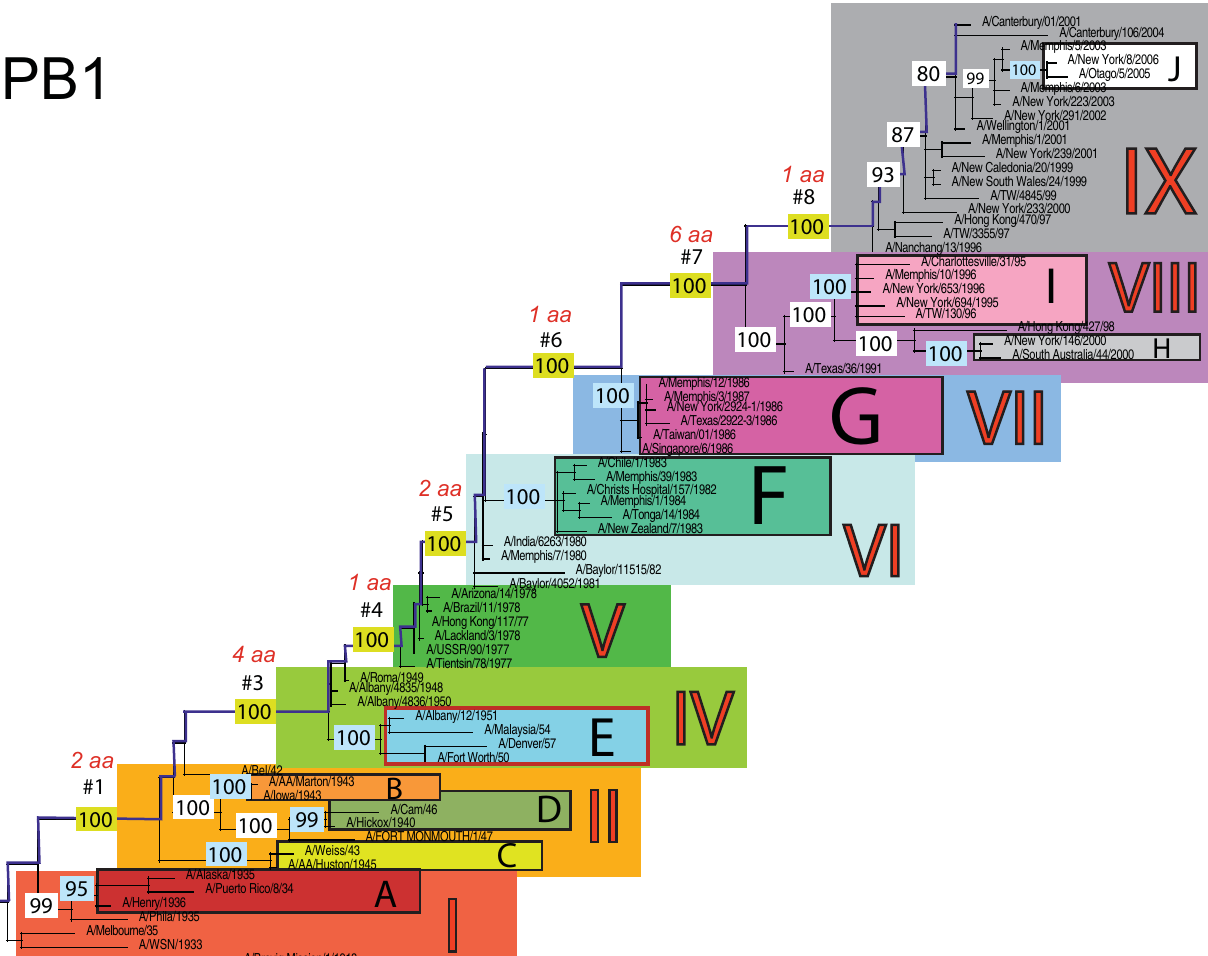
Figure 2. Phylogenetic relationships of the PB1 gene of A/H1N1 influenza viruses (n=71) sampled globally from 1918–2006, estimated using ML. Rooting, scale, and color scheme are the same as those used in Figure 1.